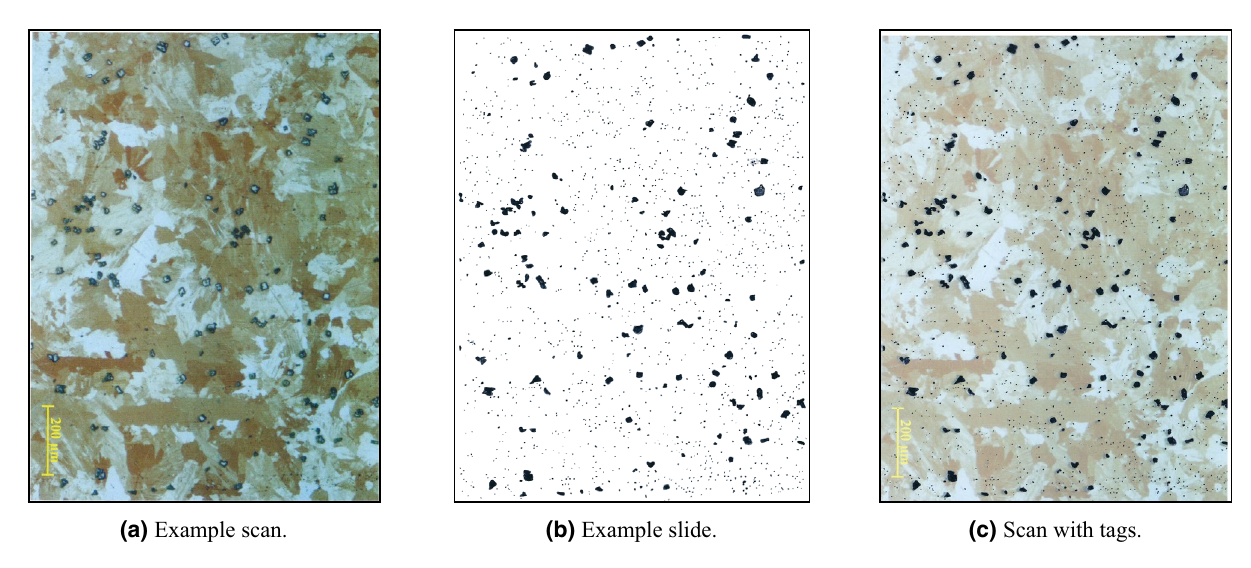
Figure 4. Example of metallographic sample with impurities